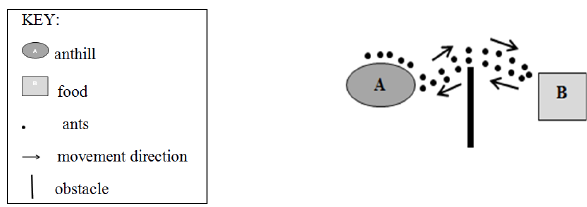
Figure 4: The final path for the ant colony to get